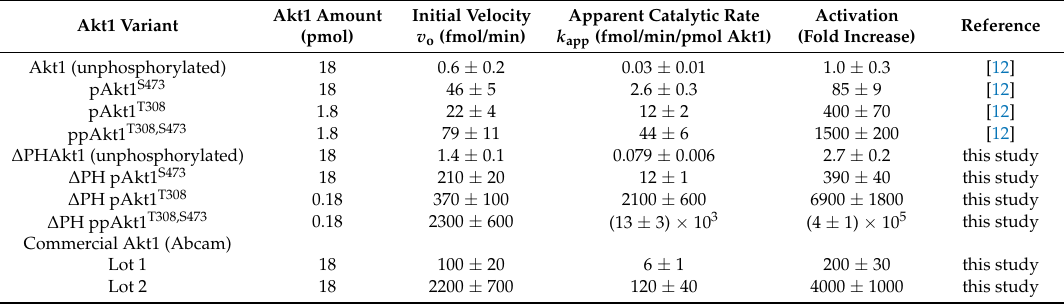
Table 2. Activity of Akt1